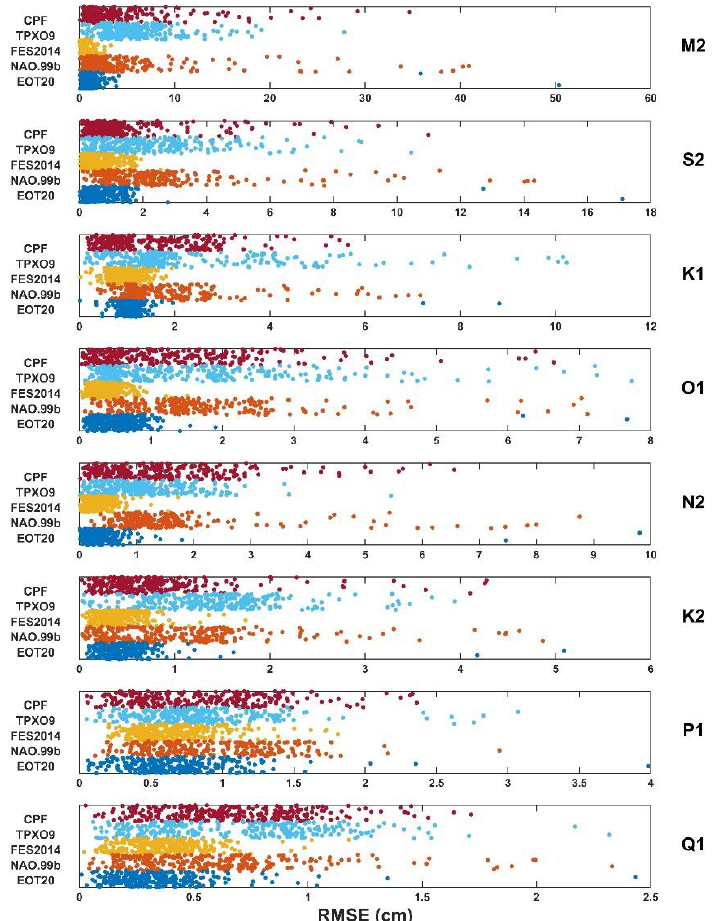
Figure 2. The RMSEs of the harmonic constants calculated by the CPF method, and those of the TPXO9, FES2014, NAO.99b and the EOT20 models, compared with each point of the X-TRACK coastal satellite observations. The CPF method: red dots; the TPXO9 model: light blue dots; the FES2014 model: yellow dots; the NAO.99b model: orange dots; the EOT20 model: blue dots.